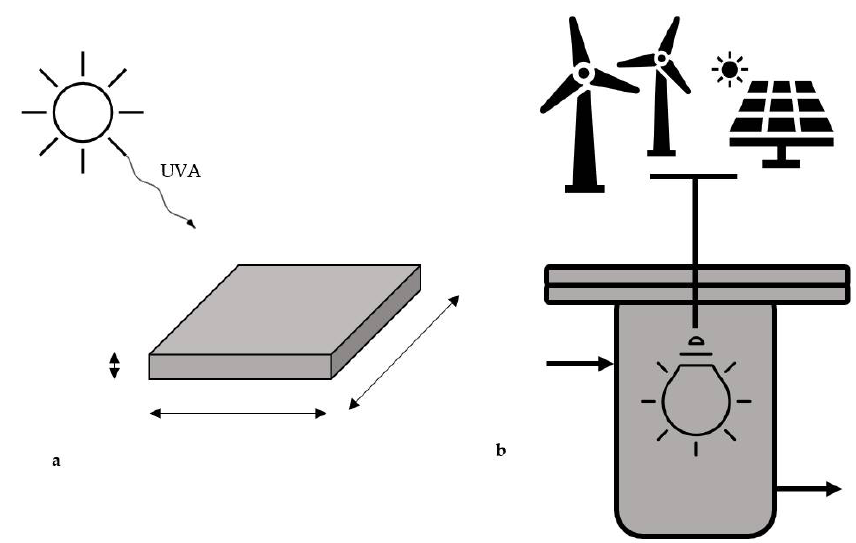
Figure 1. Scheme of the proposed photoreactor for the direct solar driven photoreduction of CO 2 ( a ) and representation of the steel reactor powered with energy from renewables ( b ).